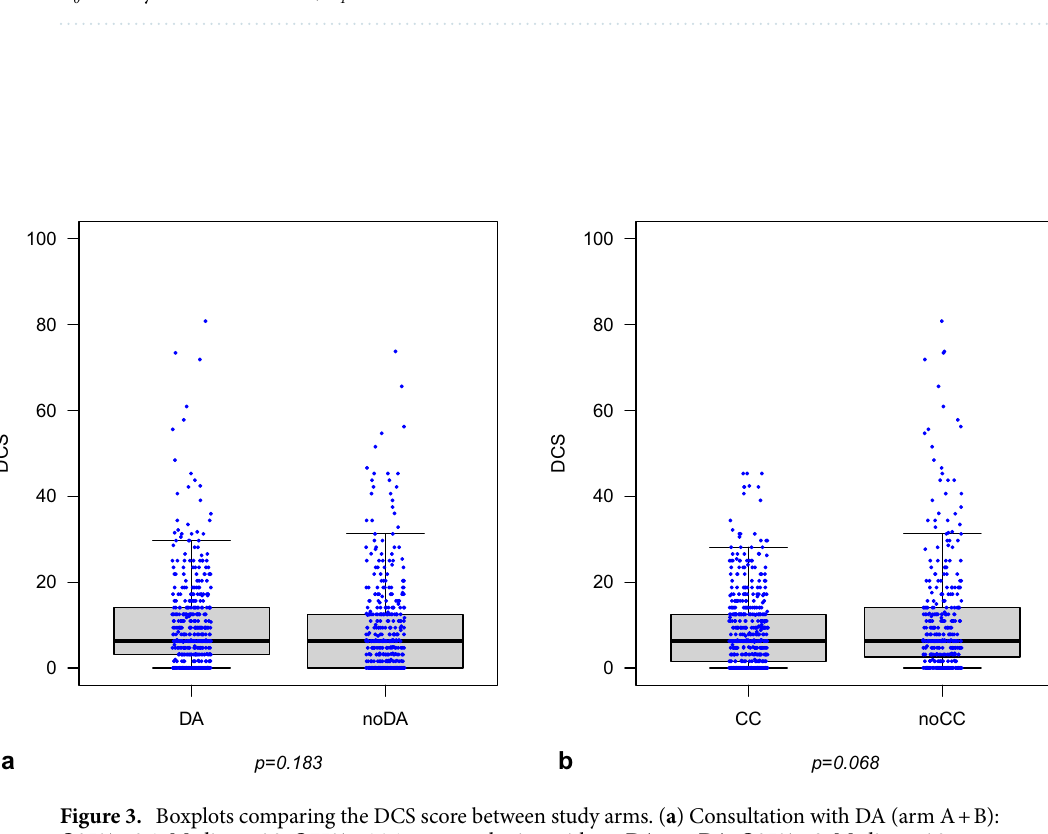
Table 1. Baseline characteristics of the participants, prior experience of early detection for PCa and compliance with the study protocol. a 5-point scale with answer options: “excellent”, “very good”, “good”, “less good”, “bad”. “Good” was placed in the middle. PSA prostate specific antigen, DRE digital rectal examination, T 0 directly after consultation, T 1 two weeks after consultation.